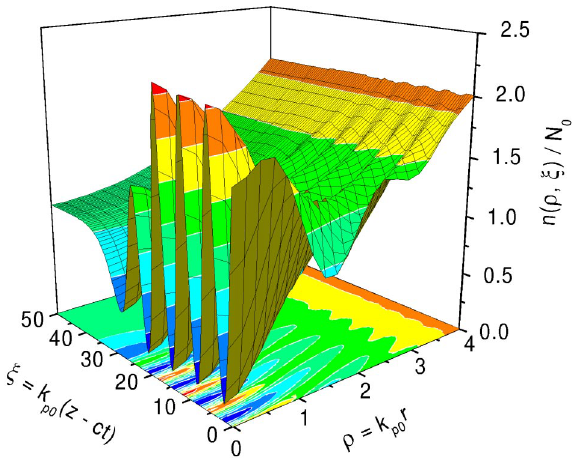
FIG. 4. (Color) Electron plasma density n (cid:8) ’; (cid:31) (cid:9) =N propagation. The parameters are the same as in Fig.